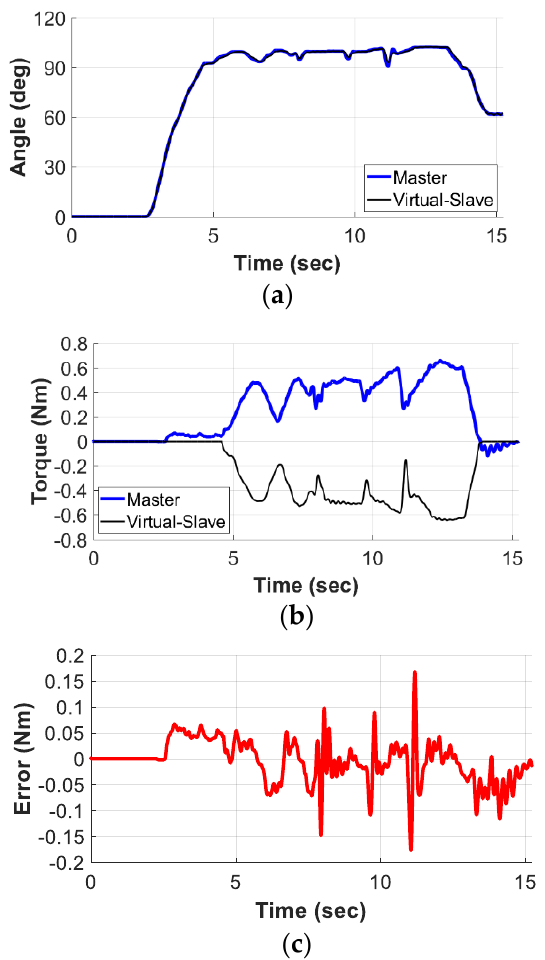
Figure 10. Results of conventional bilateral control: ( a ) position responses; ( b ) torque responses; ( c ) torque error.